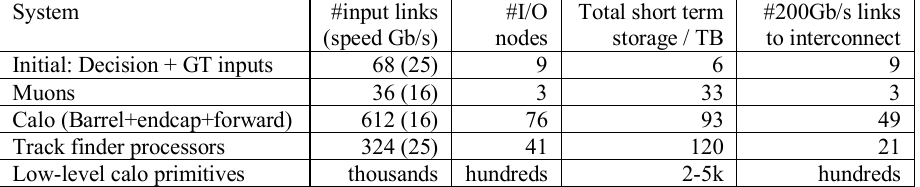
Tab. 1. Stages for the evolution of the scouting system and resource